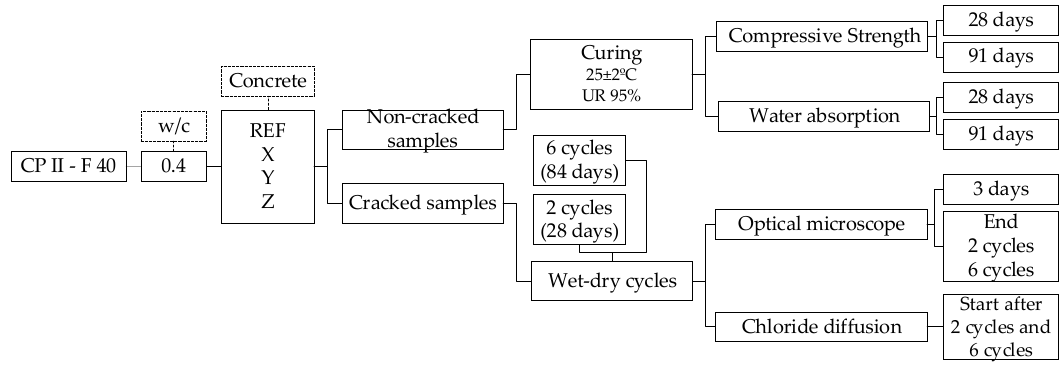
Figure 3. Experimental program.